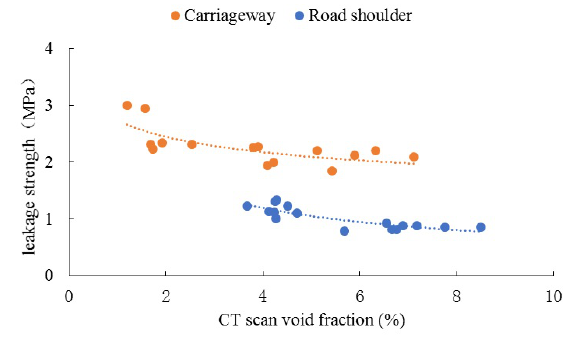
Fig. 6 Relationship between void fraction and leakage strength in CT